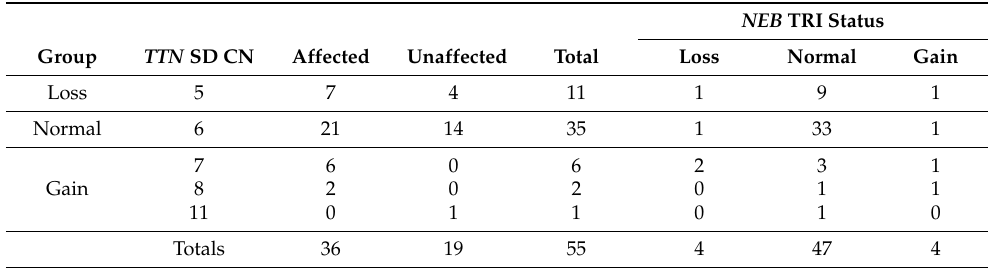
Table 1. Number of samples from affected and unaffected individuals representing different predicted classes of the TTN SD according to the NMD-CGH-array. The normal CN for the NEB TRI region is 6; any deviation from this is considered either a loss or a gain.